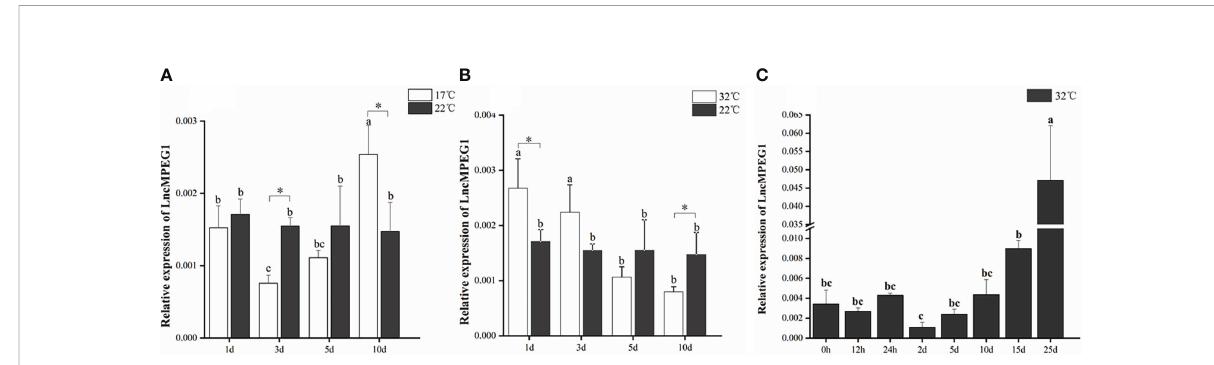
FIGURE 6 The relative expression of LncMPEG1 in the mantle tissue after the temperature treatment and hypoxic stress. The expression pattern of LncMPEG1 in the mantle tissue of P. f. martensii under 17°C stress (A) , under 32°C stress (B) , and under hypoxia treatment at a high temperature (C) . The mean values with * indicate signi fi cantly different (P < 0.05). The mean values with different letters indicate signi fi cant differences (P <